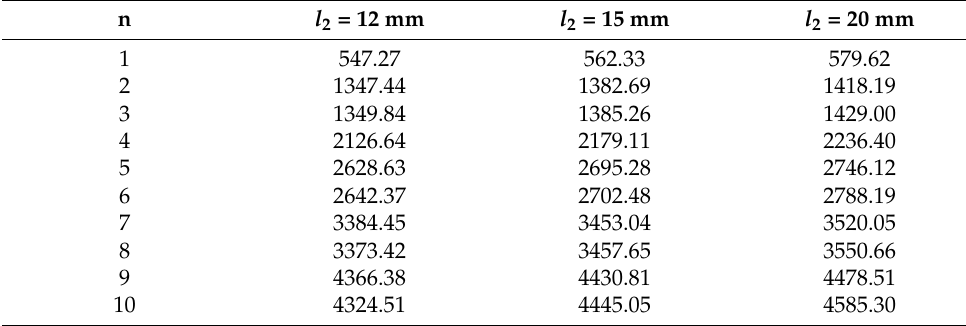
Table 4. Frequencies of ZPR honeycomb plate with l 2 change.